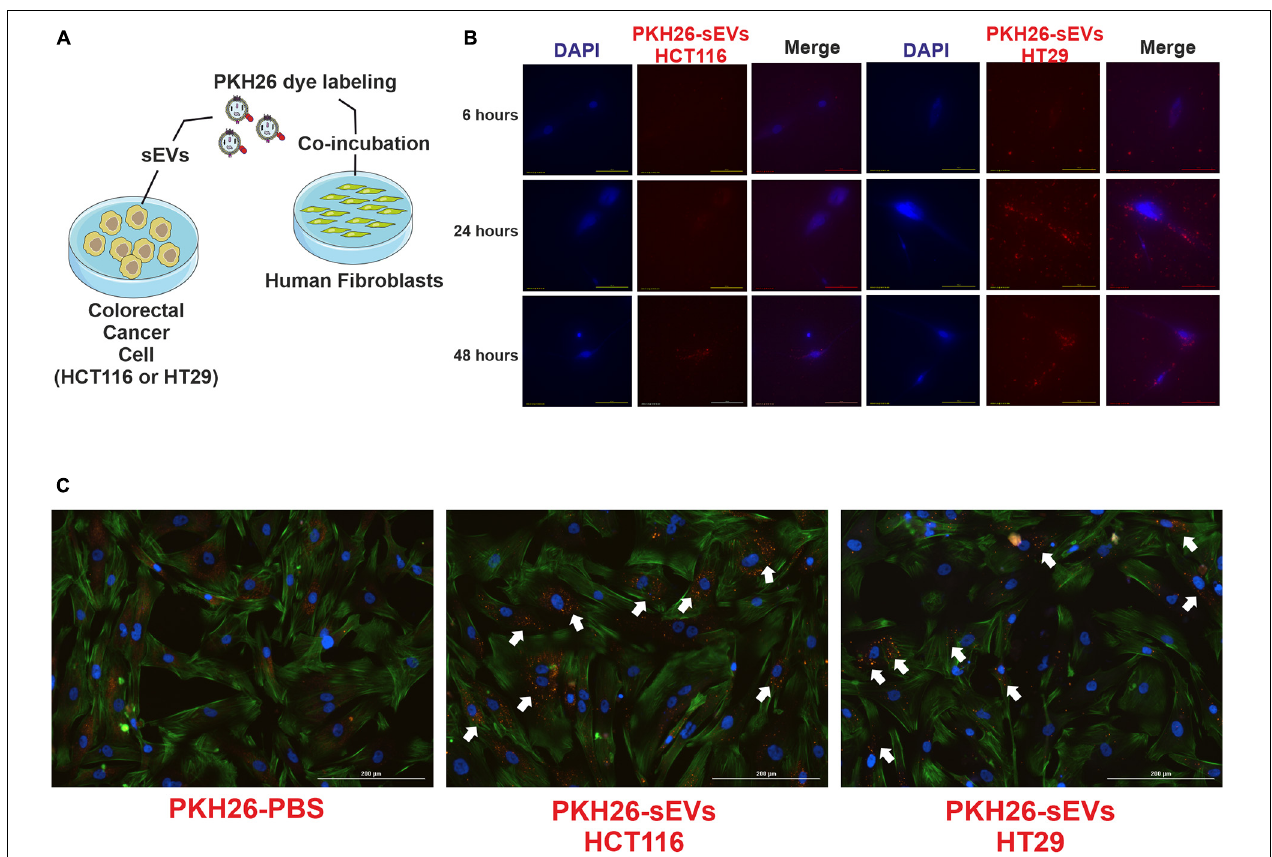
FIGURE 3 | HCT116 and HT29 cell-derived sEVs were uptake by human fibroblasts. (A) Schematic diagram of experimental procedures. CRC cell-derived sEVs labeled with PKH26 were added to culture media of human fibroblasts. (B) Fluorescent microscopic analysis of normal human fibroblasts incubated with PKH26-stained HCT116-sEVs or HT29-sEVs (2 µ g, 6, 24, and 48 h; red). Nuclei were stained with 4 (cid:48) ,6-diamidino-2-phenylindole (blue). Scale bar: 100 µ m. (C) Representative images of human fibroblasts incubated for 48 h with PKH26-stained HCT116-sEVs or HT29-sEVs (2 µ g, red); nuclei were stained in blue and actin in green (ActinGreen 488, Thermo Fisher). Scale bar: 100 µ